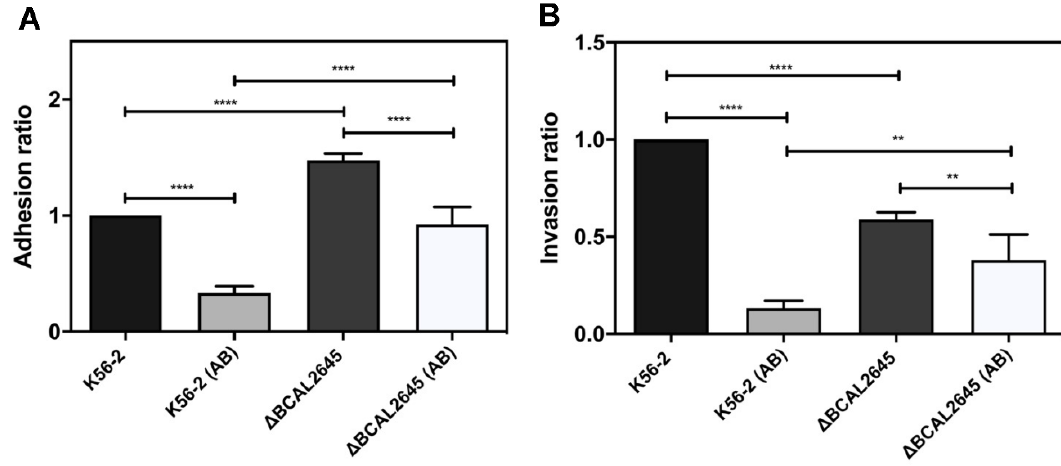
Figure 5. The polyclonal antibody anti-BCAL2645 strongly reduces the ability of B. cenocepacia to adhere and invade human bronchial epithelial cell line CFBE41o-. ( A ) Effect of the anti-BCAL2645 goat polyclonal antibody on the ability of B. cenocepacia K56-2 and ∆ BCAL2645 strain to adhere to CFBE41o- CF epithelial cell line, expressed as a ratio of B. cenocepacia K56-2 adherence. ( B ) Effect of the anti-BCAL2645 goat polyclonal antibody on the ability of B. cenocepacia K56-2 and ∆ BCAL2645 strain to invade CFBE41o- CF epithelial cell line. Both strains were incubated with the antibody for 1 h prior to adhesion and invasion experiments. All the results are from three independent experiments, and bars indicate SD. (****, p < 0.0001; **, p < 0.01, NS, non-significant).